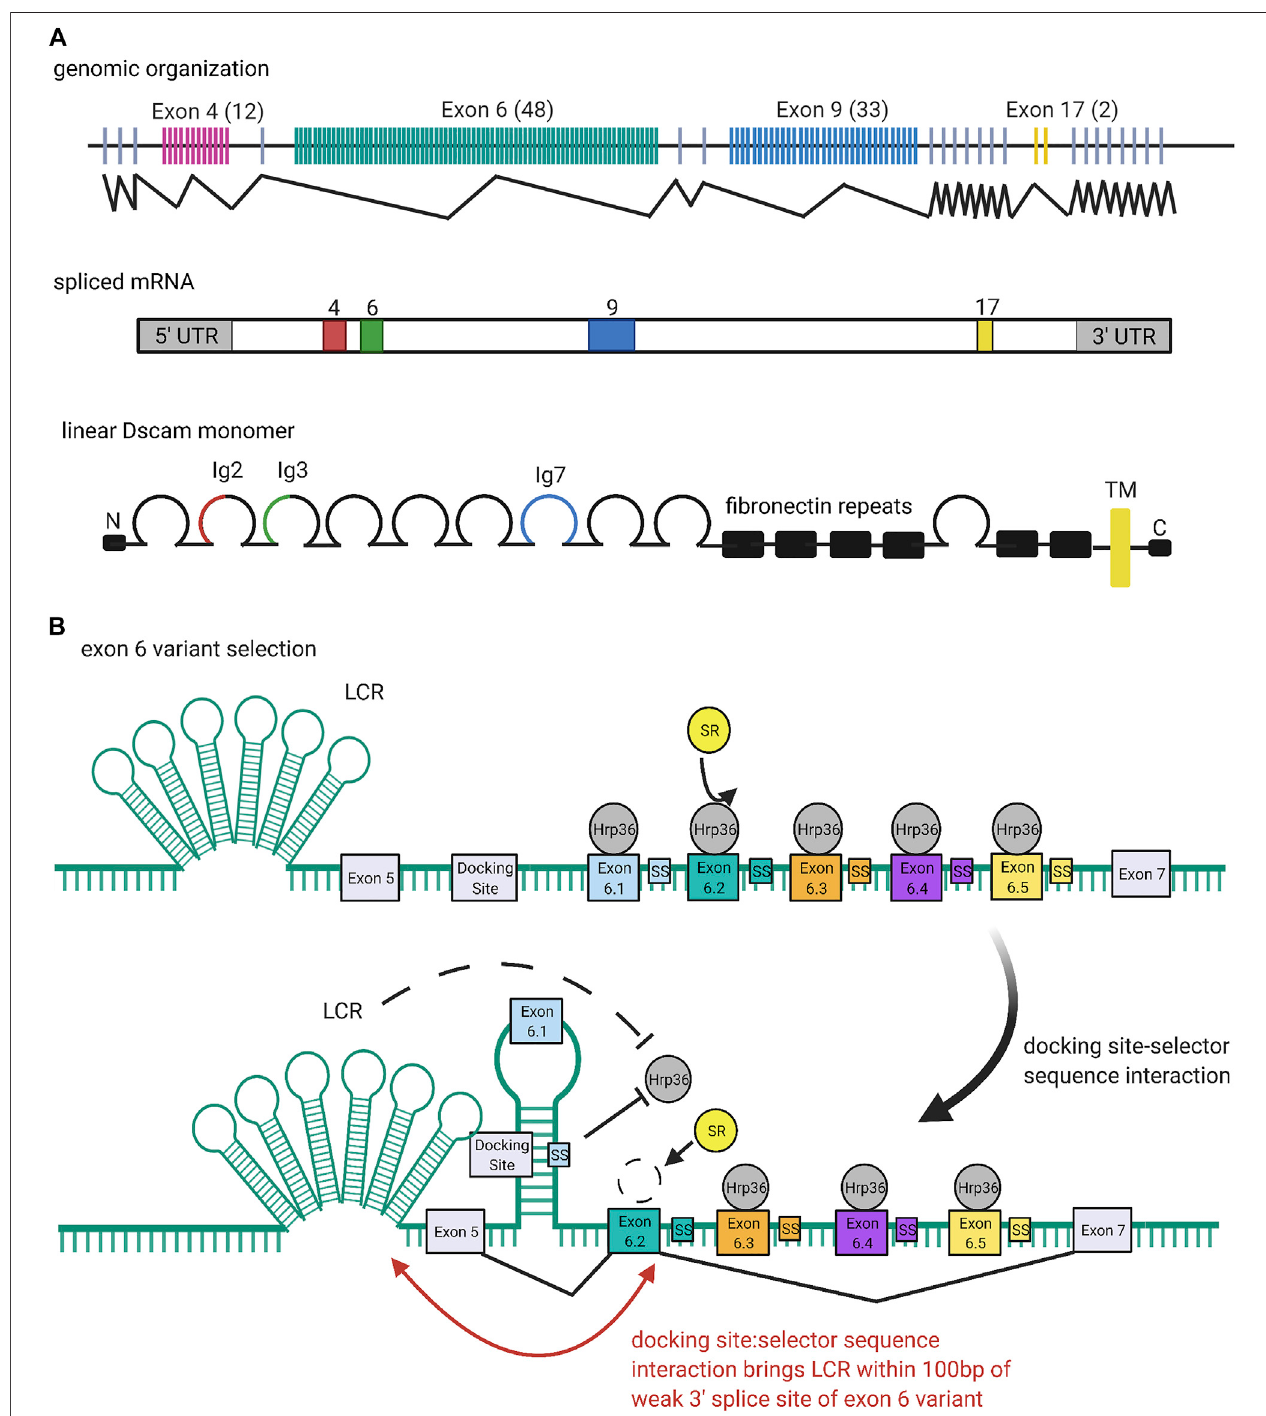
FIGURE 4 | Organization and Expression of Dscams. (A) Genomic organization of the Dscam1 locus in D. melanogaster . Numbers of exon variants are listed in parenthesesnexttotheexonclusternumber. Alternativesplicingatexonclusters4,6,9,and17(blackzigzagginglines)proceedsindependently,suchthatthe Dscam1 locuscancombinatoriallyencodeupto38,016uniqueisoforms(Schmuckeretal.,2000).Exon4(red)andexon6(green)variantsencodetheN-terminalhalvesoftheIg2 andIg3domains, respectively,whileexon9(blue)variantsencodetheentireIg7domain(Schmuckeretal.,2000;Zhanetal.,2004).Exon17(yellow)codesforone oftwoalternativetransmembranedomains,which appear toplayarolein thesubcellularlocalizationofDscams(Wang J.etal., 2004;Yang et al.,2012;Liu et al.,2020). (B) Mechanism of exon six variant exon selection; for simplicity, only the fi rst 5 exon six variants and selector sequences (colored boxes) are shown, fl anked by exons 5 and 7 and the common upstream docking site (grey rectangles). The exon 6 cluster of the Dscam1 locus is maintained in a globally repressed state by binding of Hrp36